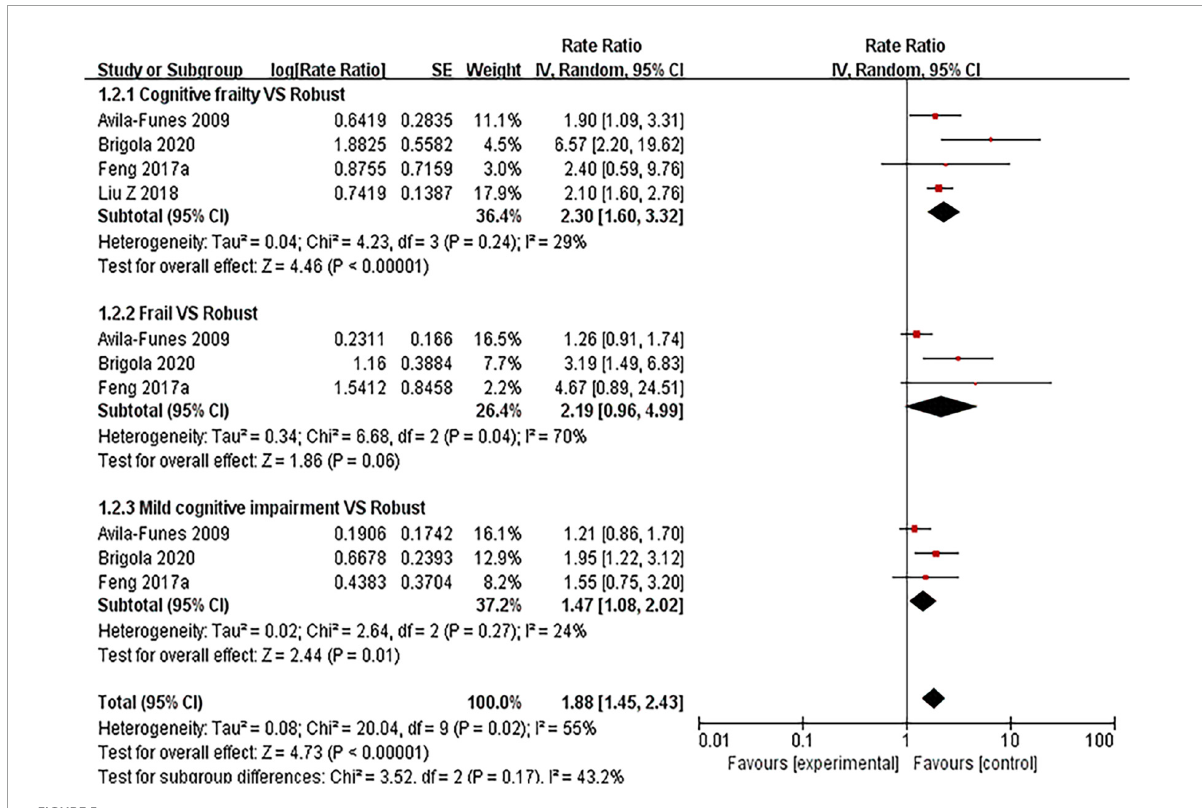
FIGURE5 Forest plot of the association between cognitive frailty, frailty, and mild cognitive impairment and hospitalization in older adults (reference group: participants were free of frailty and mild cognitive impairment), using random-effects meta-analysis. 95% CI, 95% confidence